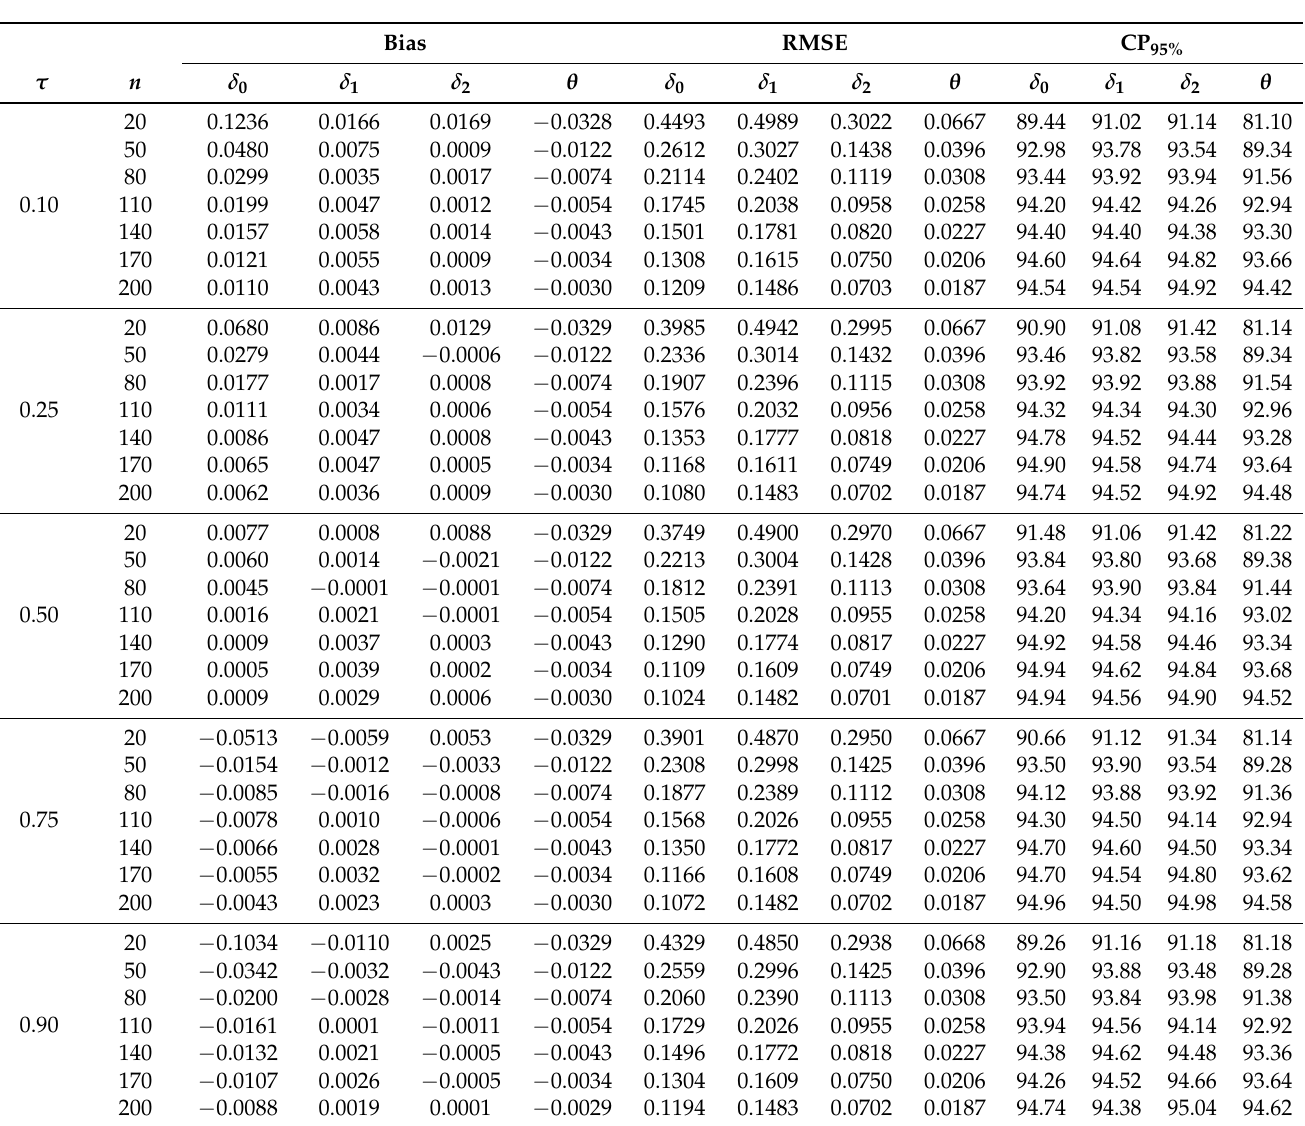
Table 4. Empirical bias, RMSE, and 95% CP (true values: δ 0 = 1.00, δ 1 = 1.00, δ 2 = 0.50, and θ = 0.25) with simulated data.